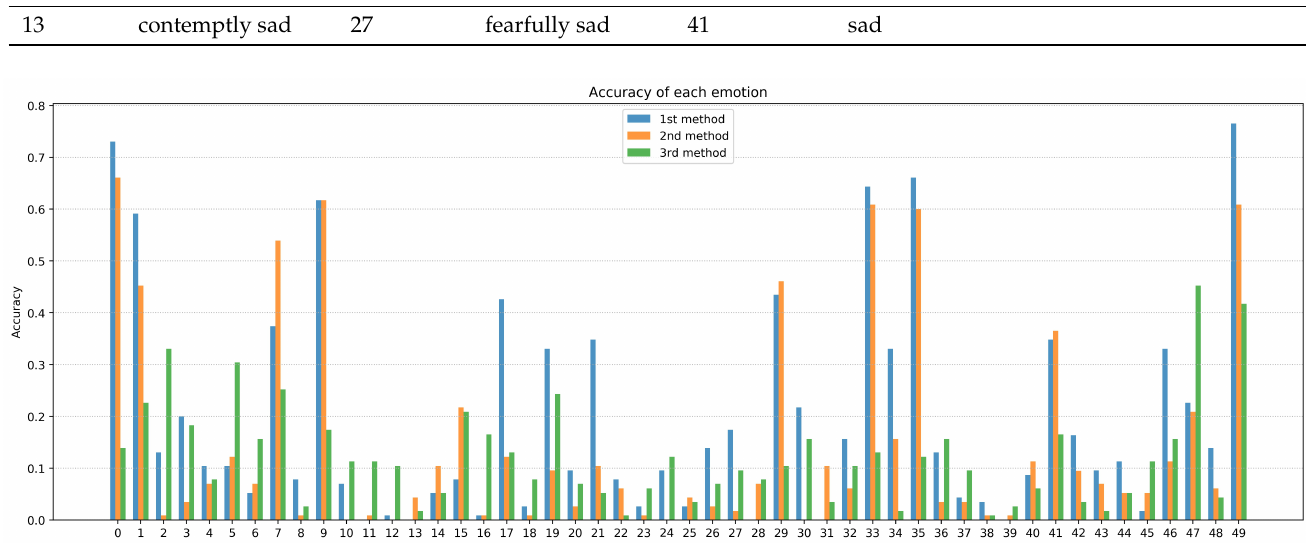
Figure 3. The accuracy of the three baseline methods (multimodality network with visual and geometrical information, unsupervised learning of CNN and face alignment images trained with inception-V3 model and centre loss, respectively) of each category of emotion on the testing set of the iCV-MEFED